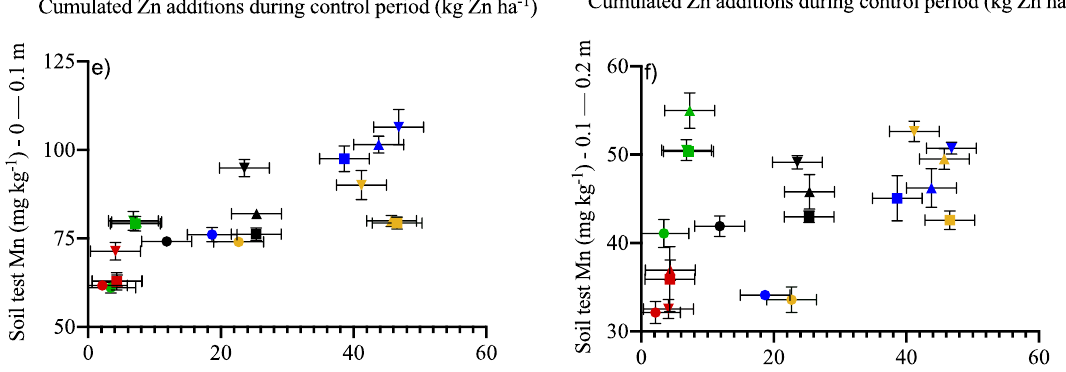
Figure 4. Change in the soil Cu ( a , b ), Zn ( c , d ), and Mn ( e , f ) during the 2009–2020 period in the 0–0.1 and 0.1–0.2 m layers, respectively, as impacted by fertilizer regimes. Error bars represent standard errors of the